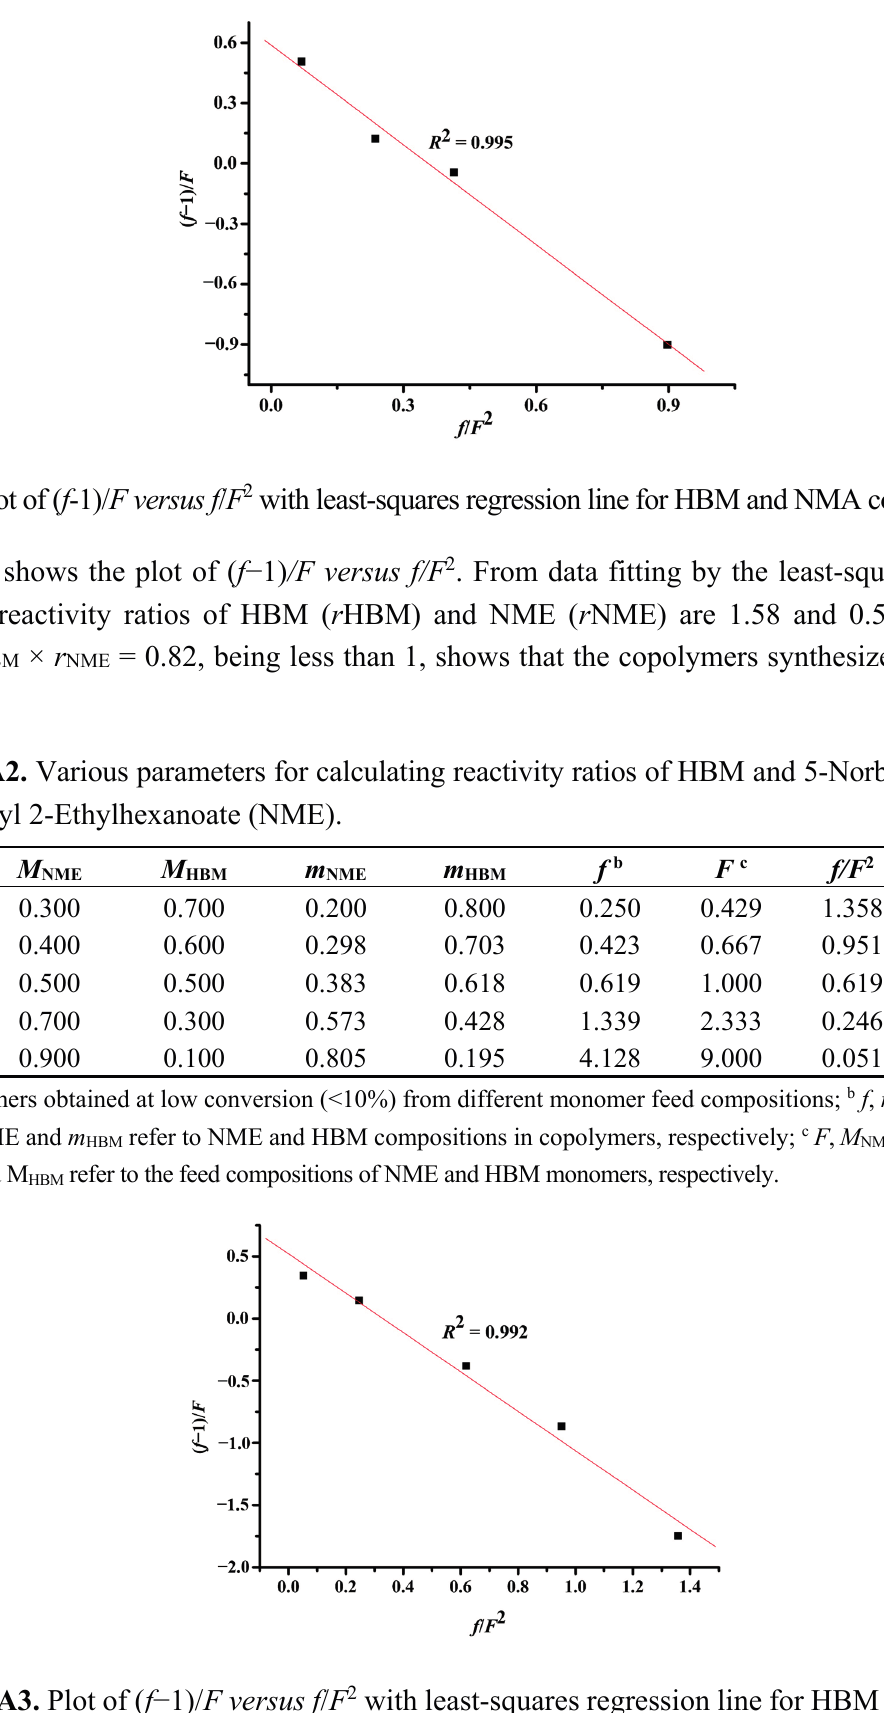
Figure A3. Plot of ( f − 1)/ F versus f / F 2 with least-squares regression line for HBM and NME